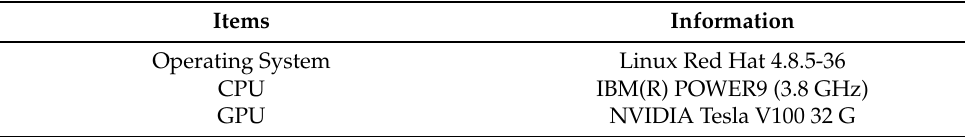
Table 1. Experimental environment